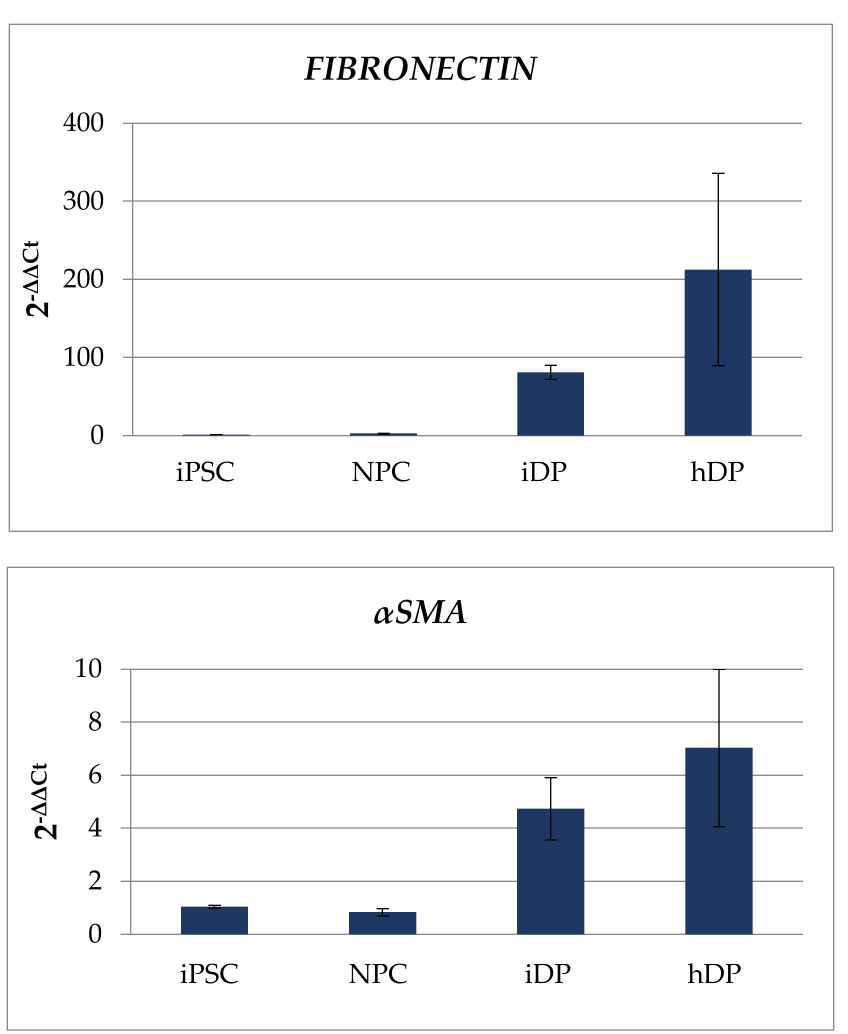
Figure 3. Expression of specialized markers in iPSC, NPC, iDP, and hDP cell lines. Quantitative PCR analysis: OCT4, SOX2, NANOG, PAX6, NESTIN, β 3-TUBULIN, VIMENTIN, FIBRONECTIN, α SMA .